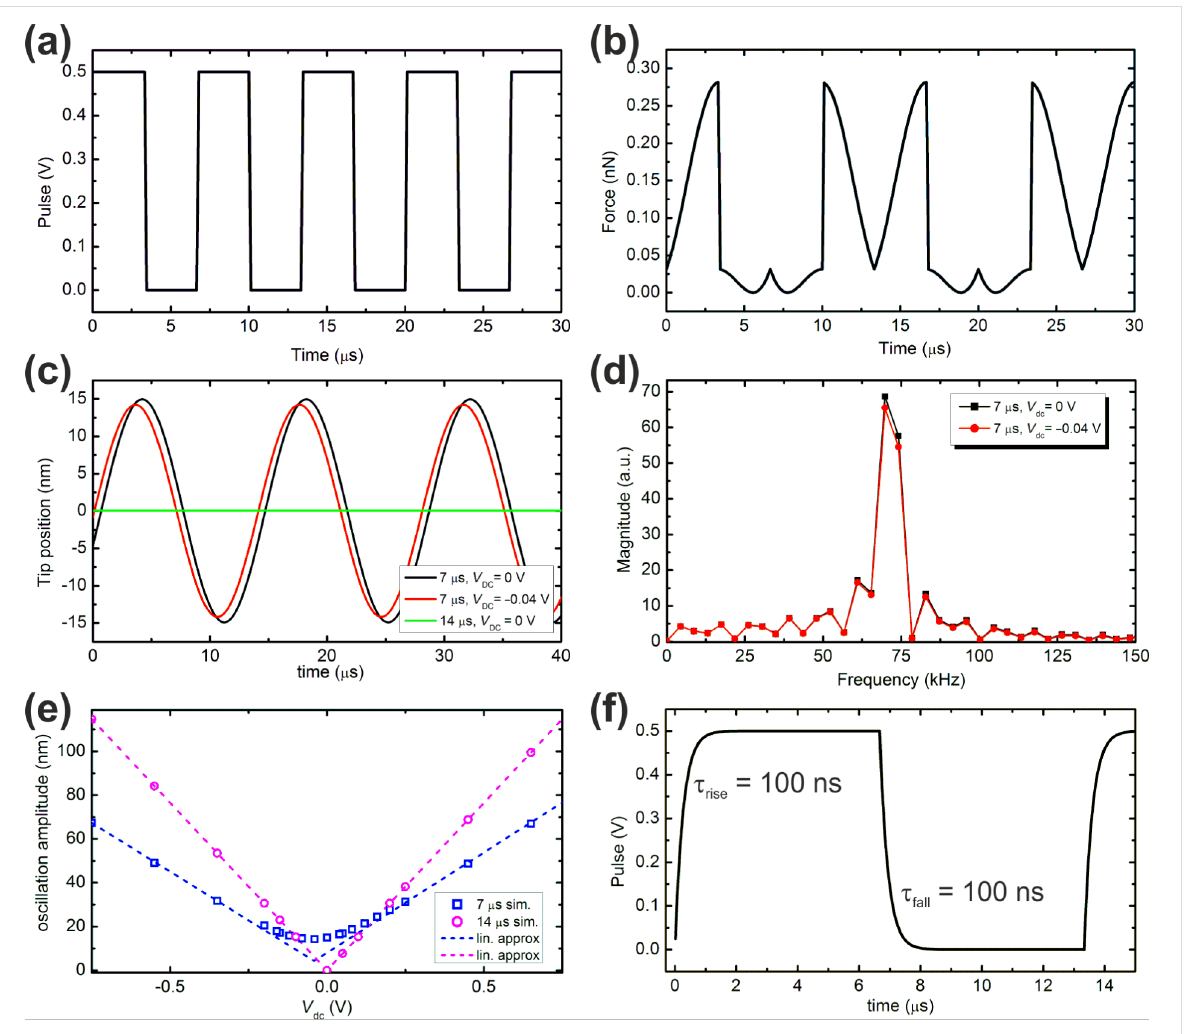
Figure 1: (a) Perturbation signal with a square pulse shape, exemplarily shown for a period of 6.67 μ s, a pulse width of ½ the period (3.33 μ s), and an amplitude of 0.5 V. (b) Total electrostatic driving force acting on the cantilever for the application of the above pulse plus a dc-bias voltage of − 250 mV. (c) Tip oscillation for three different conditions as indicated in the legend, showing that not in all cases a dc voltage can be found to reduce the tip oscillation to zero. (d) FFT spectra of the tip oscillation for the two cases shown in (c). (e) Simulated oscillation amplitude as a function of applied dc voltage showing the expected v-shape of the amplitude. (f) Pulse shape with exponential raise ( τ rise = 100 ns) and fall ( τ fall = 100 ns) used in some of the presented